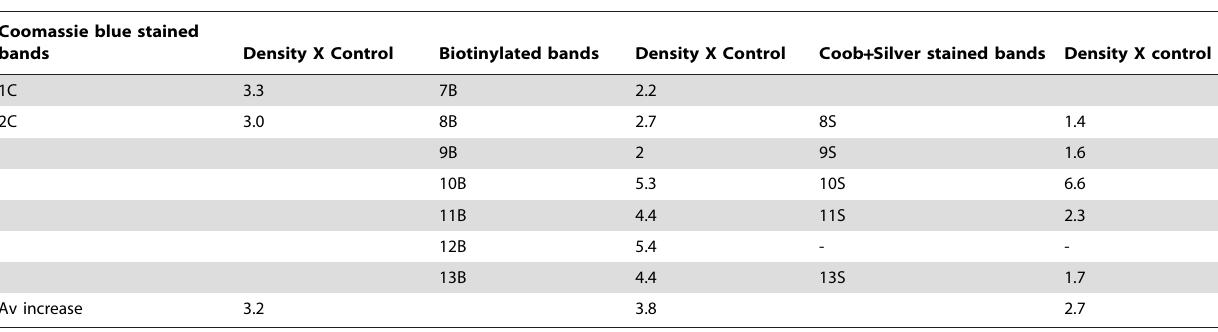
Table 2. Densitometric analysis of shed FM from control and sodium pyrophosphate-treated cells.